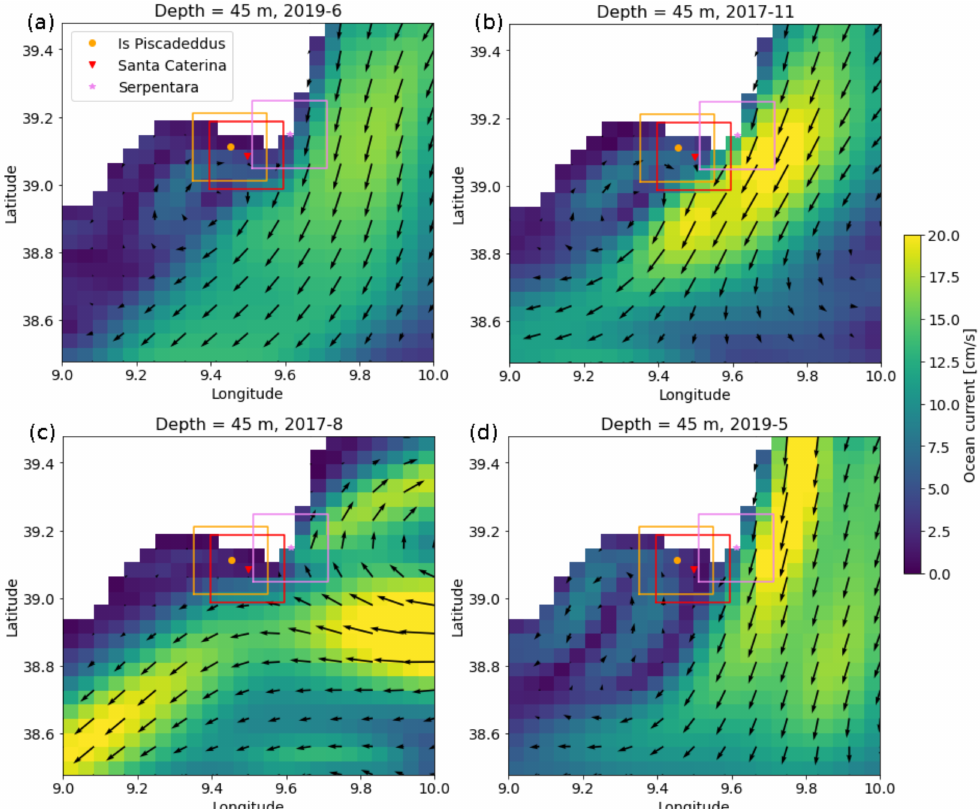
Figure 7. Example of the maps of monthly mean currents at 45 m depth from the MEDSEA reanalysis product. ( a , b ) show a dominant current (10–15 cm/s, directed S-SW), characterizing the eastern side of Capo Carbonara and deviating westward, generating a weaker closed anticyclonic loop current to the W. ( c , d ) are examples of the rare configuration of the local circulation with no anticyclonic